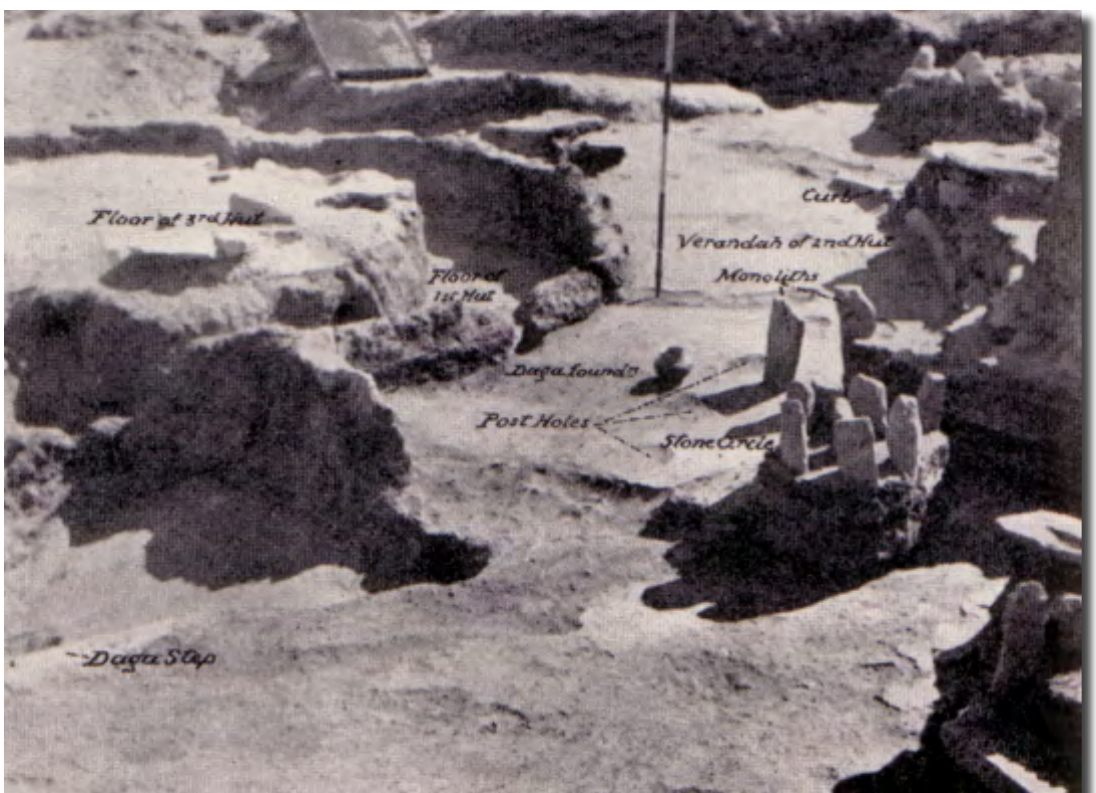
Figure 9. Architectural features in the Occupation Area exposed in Excavation JS 2(b) in 1934 (Fouché 1937:13; Plate VIII, 6), including the floor and wall base remains of a veranda type circular pole and daub structure, a stone circle consisting of stone columns in vertical position, and nearby small